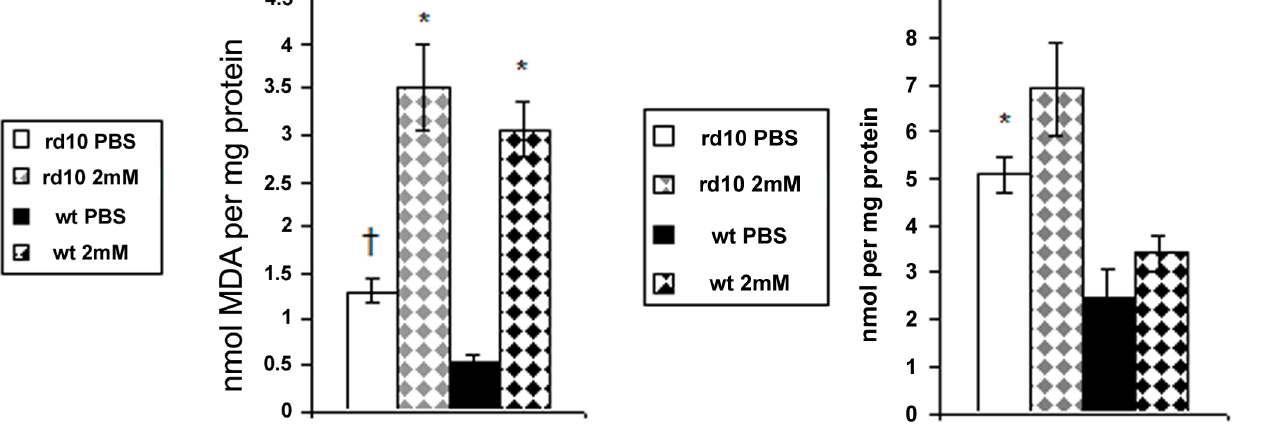
Figure 6. Protein carbonyl content (PCC) in mice retinas following PQ injection. Protein carbonylation was measured to assess oxidative retinal injury to proteins. It was assessed in retinas of rd10 and WT mice injected with 1 m l of 2 mM PQ or PBS. In both strains PQ injections caused an insignificant 1.35 fold increase of PCC. *p=0.009 comparing control (PBS) rd10 with WT retinas (n=5 in each group).